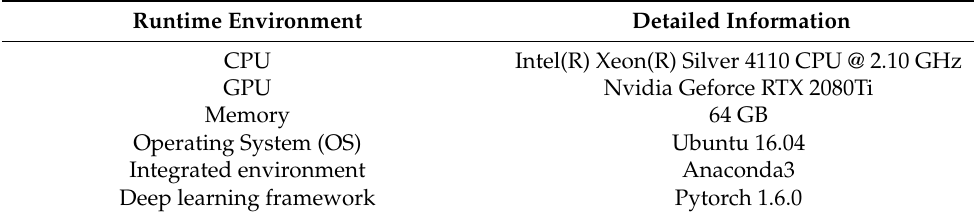
Table 2. Experimental environment.